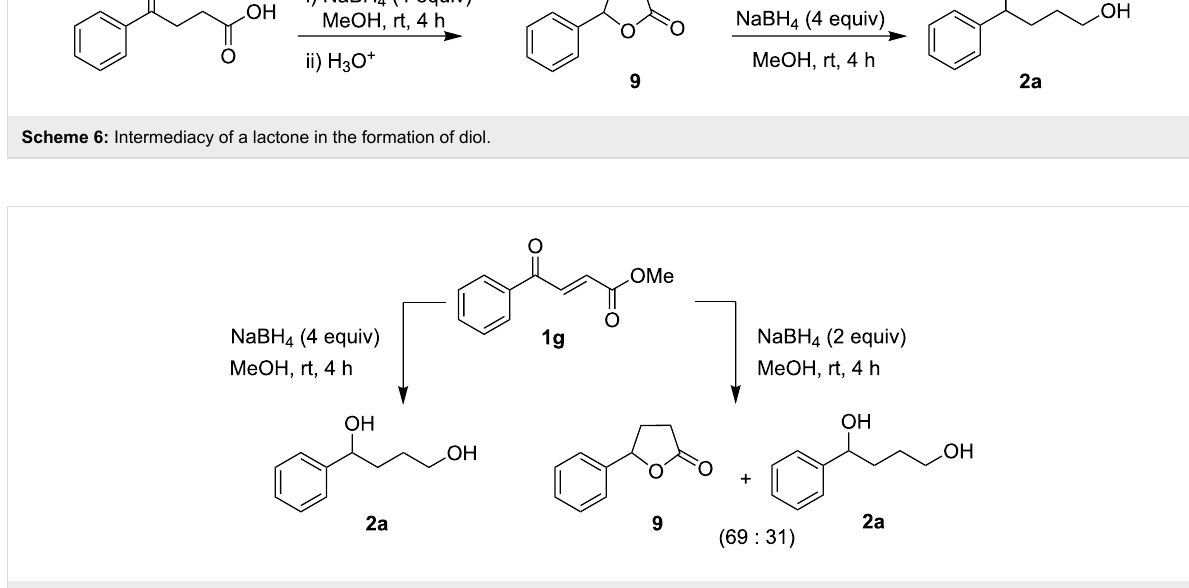
borohydride (1.2 equiv) was employed, we obtained the corres- ponding γ -hydroxy- trans - α , β -enoic ester 10 from 1g